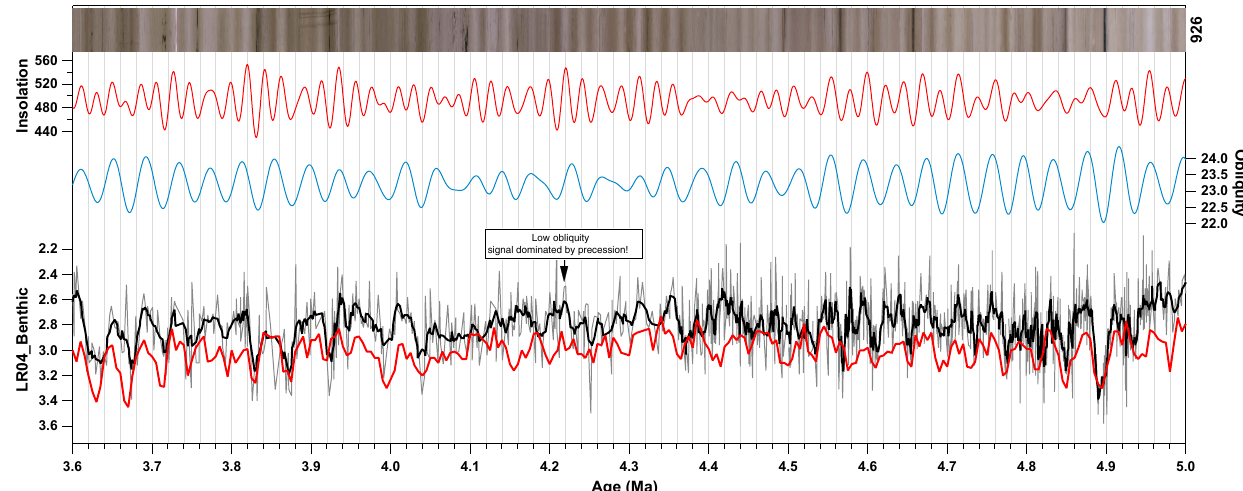
Figure 11. A comparison of LR04 (Red) to Ceara Rise (grey and black (smooth)) to obliquity and insolation from Laskar et al. (2004). Note that the interval 4.0 and 4.5Ma exhibits poorly defined obliquity cycles leaving insolation dominated by precession.